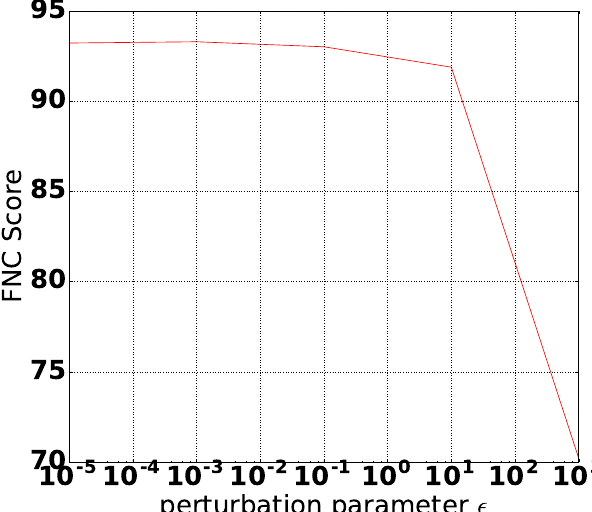
Figure 5. Perturbation parameter and performance of the model.